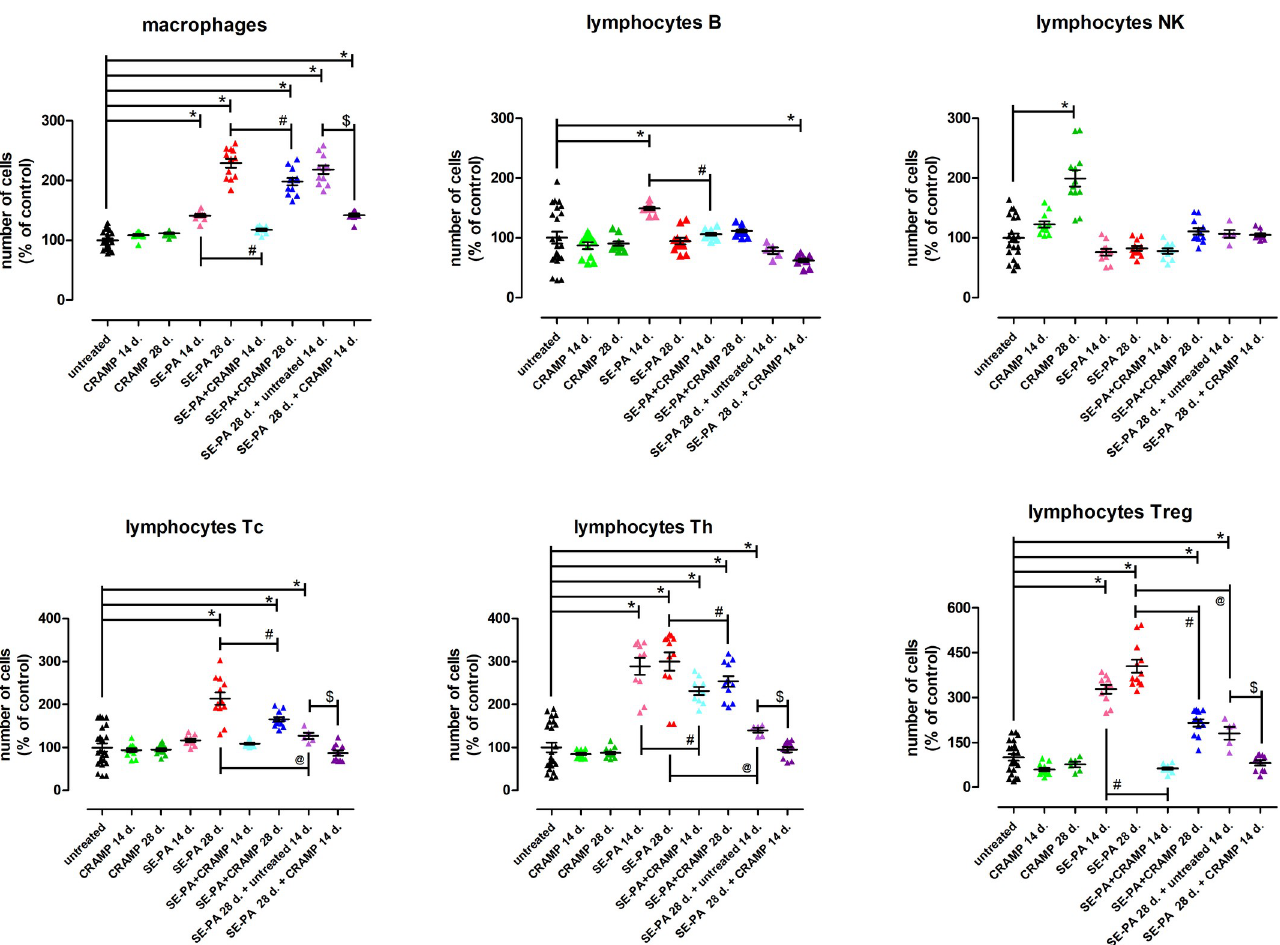
Fig 2. Changes in immune cells composition in response to cathelicidin (CRAMP) and/or Saline Extract of Pantoea Agglomerans (SE-PA) treatment. Cells number was investigated in lungs collected from untreated mice and mice exposed to investigated compounds for 14, 28 or 42 days using flow cytometry. The data are presented as mean of cell number ± SEM. Each research group contained 8 mice: 6 treated and 2 untreated animals. Samples were collected from all animals and analyzed in 2 replications. (control mice N = 16; treated mice per research group N = 6). � p < 0.05 vs. untreated; # p < 0.05 SE-PA+CRAMP 14 d./28 d. vs. SE-PA 14 d./28 d. (comparison within corresponding time points); @ SE-PA 28 d. + untreated 14 d. vs. SE-PA 28 d.; $ p < 0.05 SE-PA 28 d. + CRAMP 14 d. vs. SE-PA 28 d. + untreated 14 d.; one-way ANOVA test; Tuckey post-hoc test.